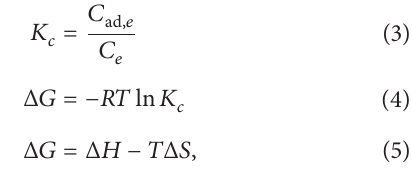
decreased to the data of 82.5% and 63.6%, respectively. The situation was expected because the total available adsorption sites were limited for the fixed adsorbent dosage [44].